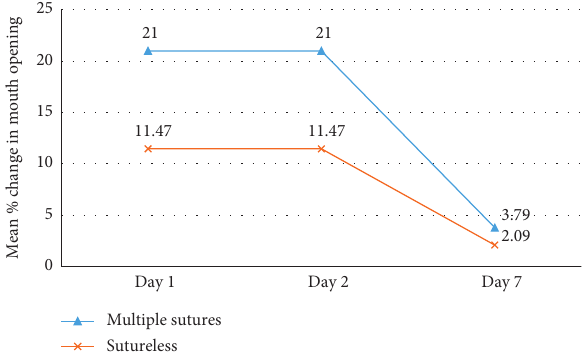
Figure 4: Comparison of trismus (mouth opening) between group 1 (multiple sutures) and group 2 (sutureless) on patients under- going third molar